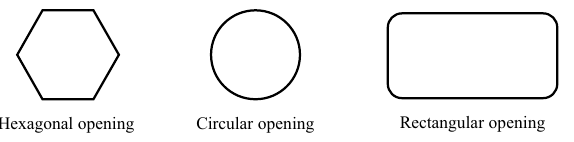
Fig. 1. Various types of web